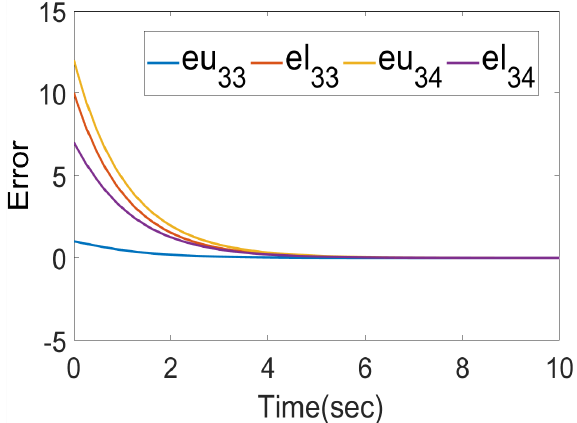
Figure 7. The error between the observer and the original system of the third manipulator.